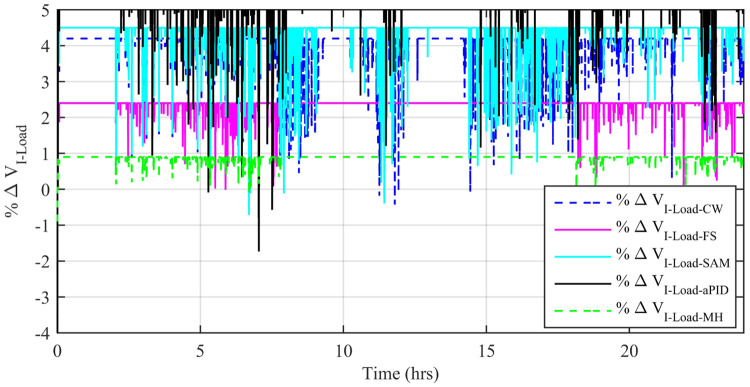
%age VRMS change.